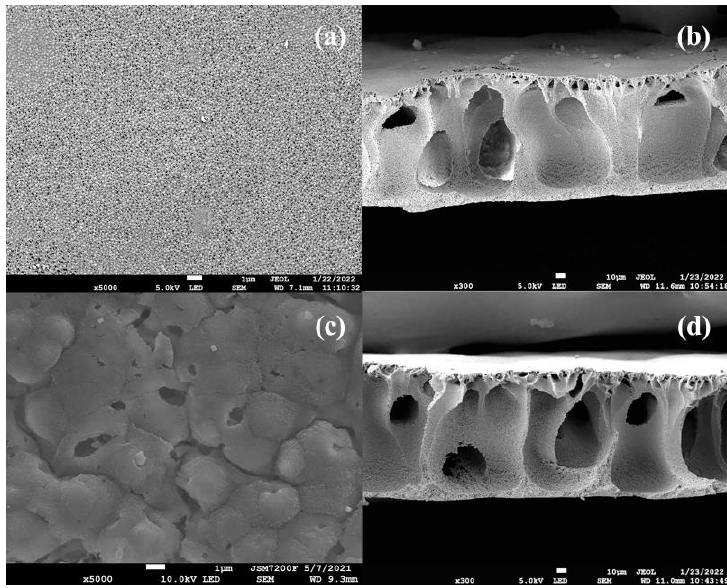
Figure 5. SEM images of the ( a ) top surface and ( b ) cross-section of the raw PVDF membrane, and ( c ) top surface and ( d ) cross-section of the g-C 3 N 4 /Ag 3 PO 4 /TiO 2 /PVDF membrane.